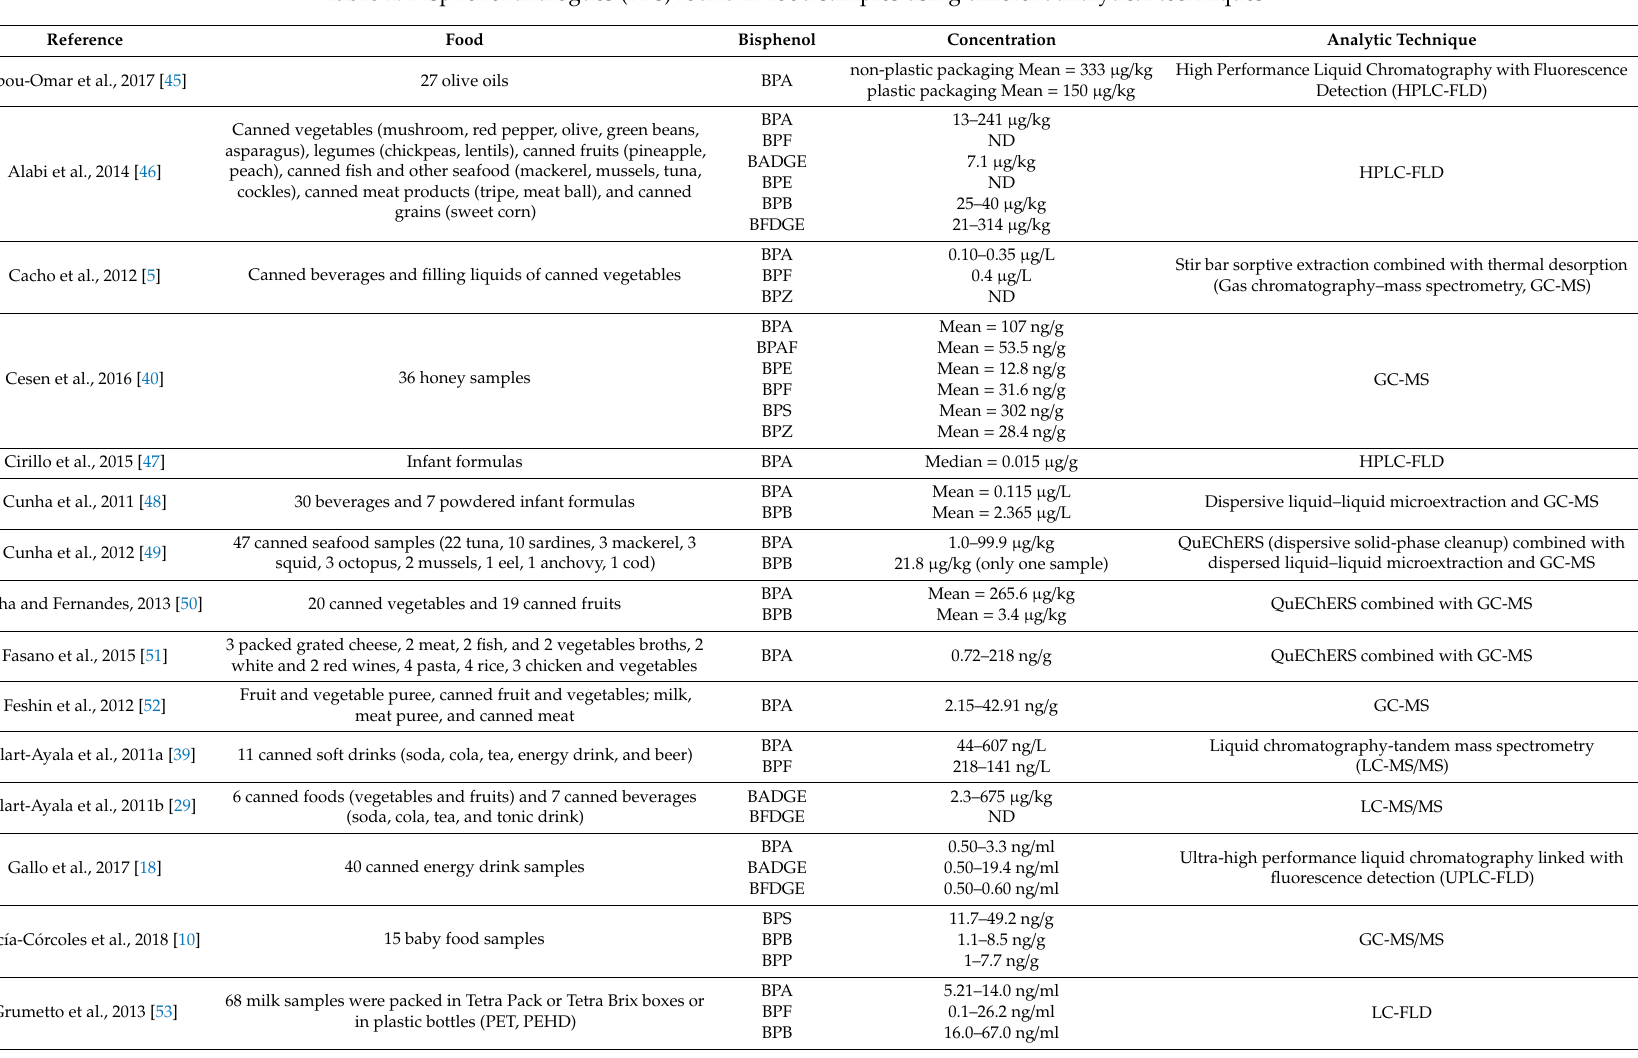
Table 1. Bisphenol analogues (BPs) found in food samples using di ff erent analytical